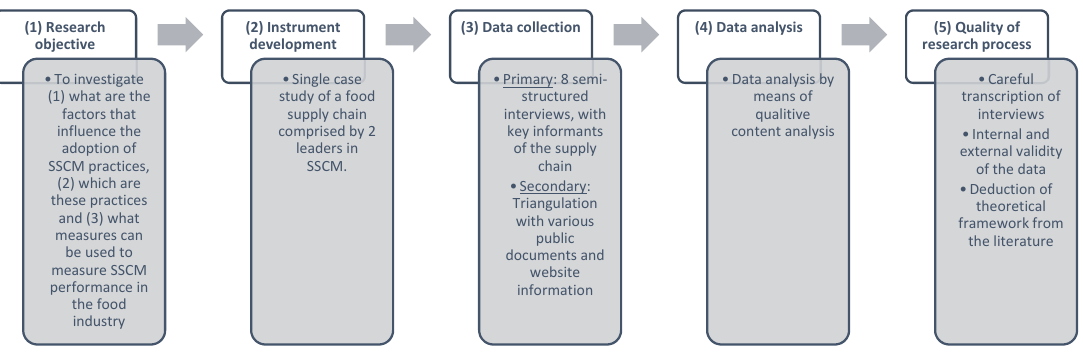
Figure 1. The five stages of the research process model. Table 1. Sample characteristics.